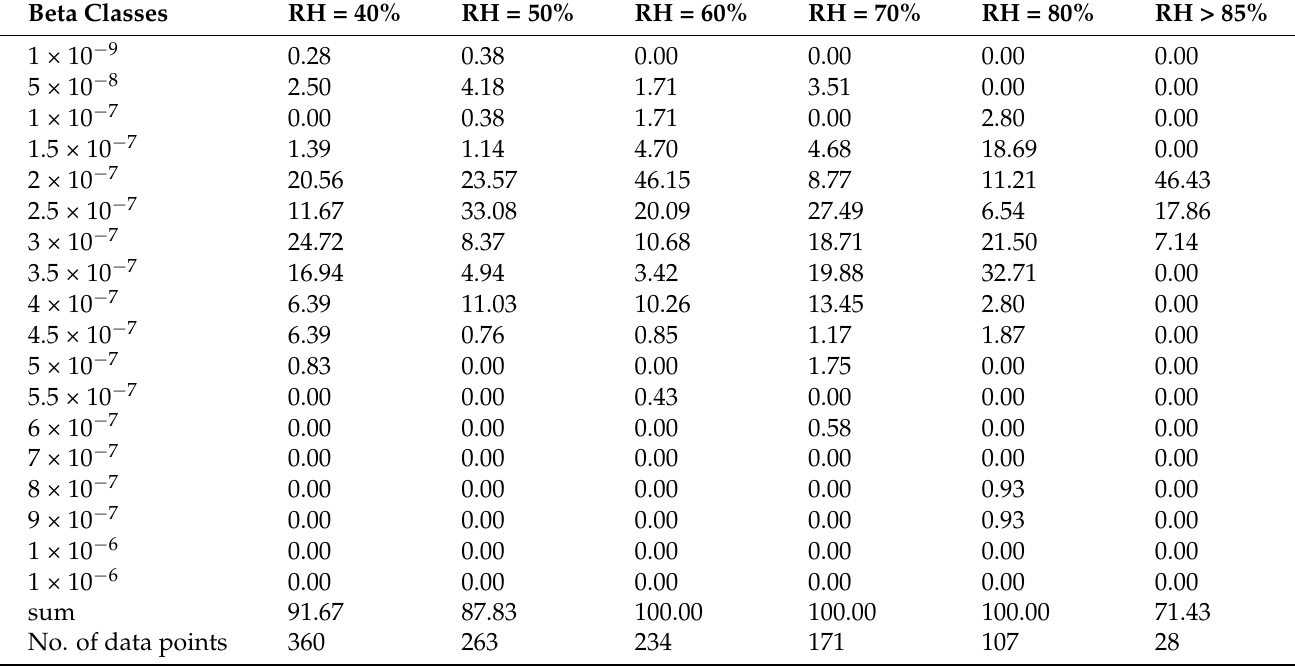
Table A1. Relative frequencies the aerosol backscatter at 532 nm between 1500 and 2000 m for different RH values. Beta